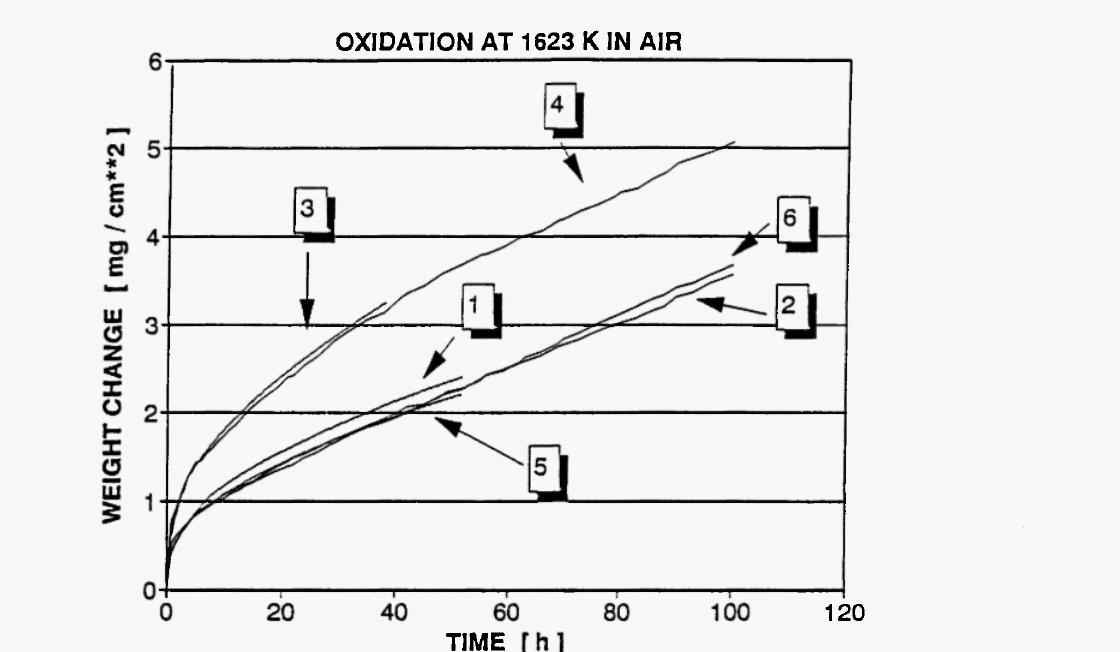
Fig. 8: Thermal cycling results at 1623K (1 cycle - 1 h) compared to isothermal oxidation results: 1, 2 - alloy Fe- 19Cr-5Al, isothermal and thermal cycling conditions, respectively; 3, 4 - alloy Fe-19Cr-5Al + 0.27Y, isothermal and thermal cycling conditions, respectively; 5, 6 - alloy Fe-19Cr-5Al, implanted with yttrium, using energy beam of 70 keV and fluence of 2x10 16 Y + /cm 2 , isothermal and thermal cycling conditions,